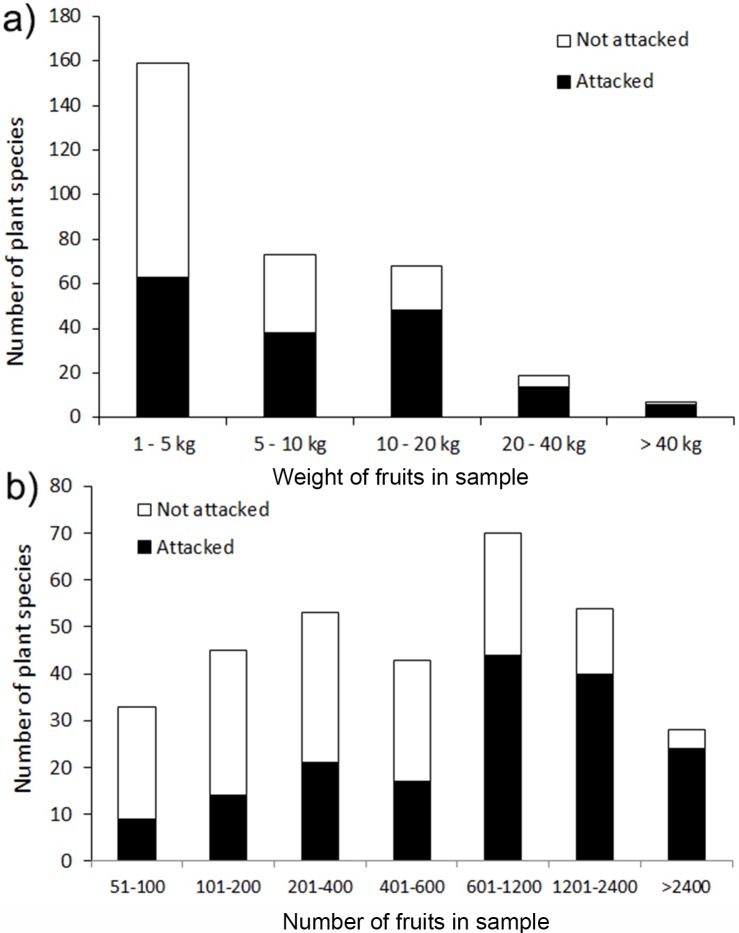
The number of plant species attacked (black bar) and not attacked (white bar) by frugivorous Lepidoptera in samples categorized by (a) fruit weight and (b) the number of fruits.